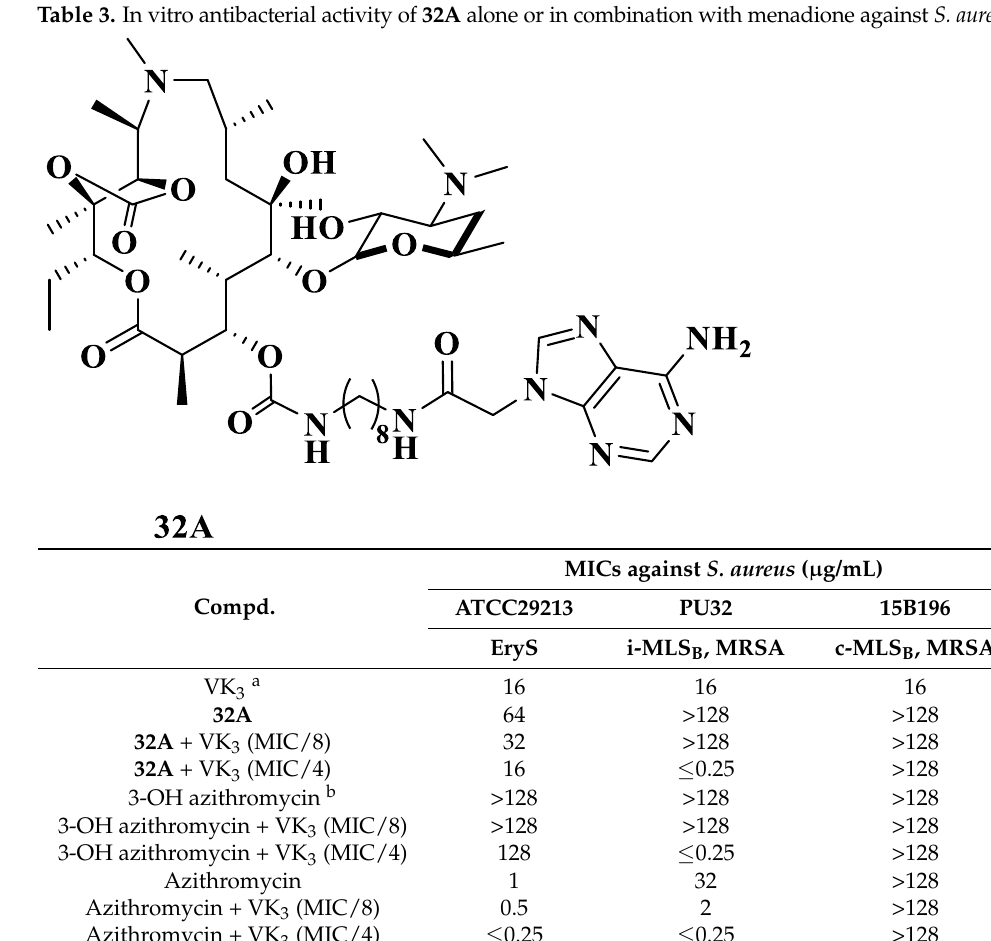
Molecules 2023 , 28 , x FOR PEER REVIEW